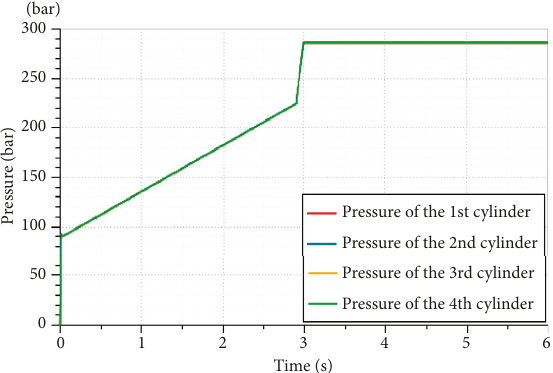
Figure 11: Pressure of four cylinders without rod